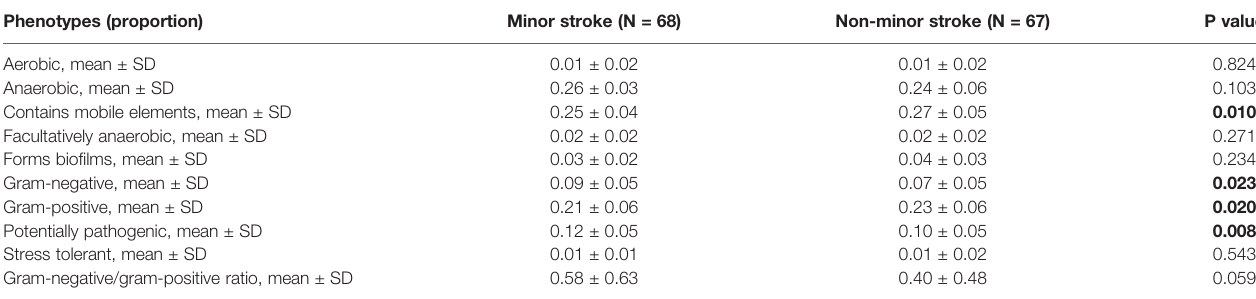
Bold value: p value with statistical signi fi cance. SD, standard